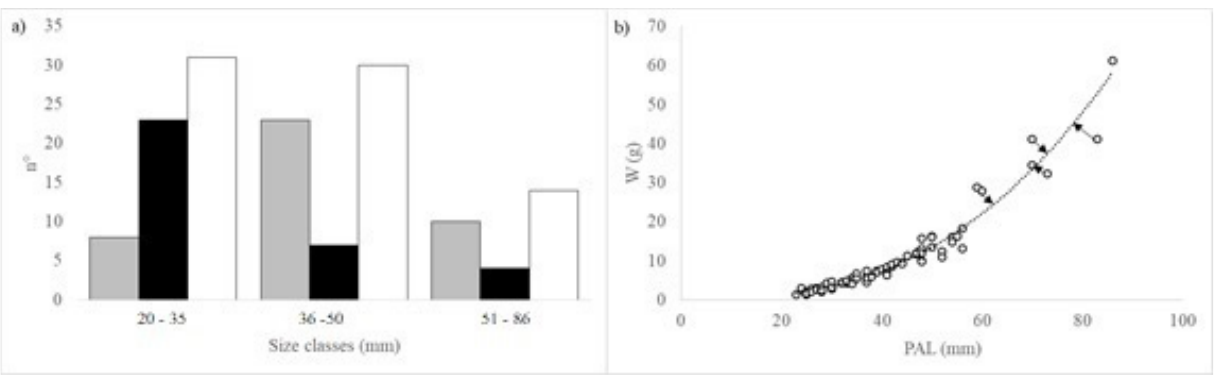
Figure 2. ( a ) Frequency size distributions of Coelorinchus caelorhincus according to periods (grey: cold period; black warm period) and as total (white). ( b ) Length (PAL: pre-anal length in mm)-weight (W: weight in g) growth relationship according to the equation: W = (4 ∗ 10 − 4 ) × PAL 2.69 , R 2 = 0.96. Arrows indicate larger deviance of larger specimens from the general regression model.